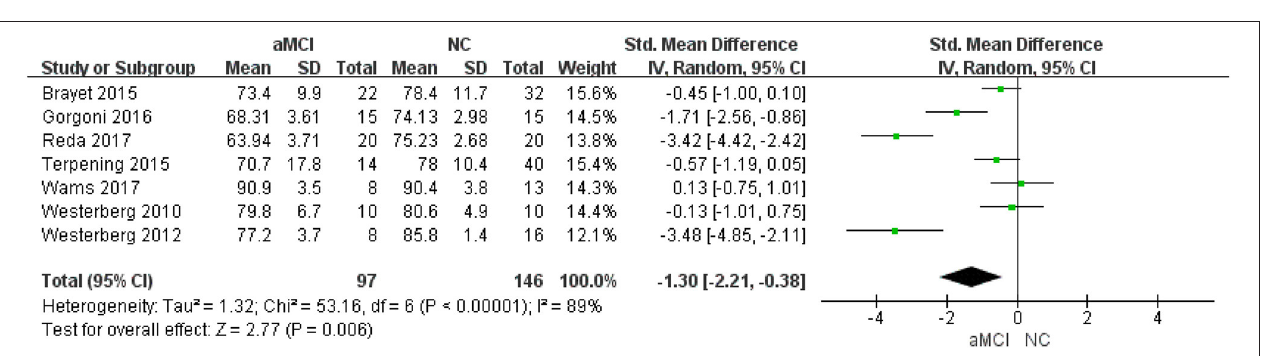
FIGURE 4 | Meta-analysis of SE between the aMCI and NC